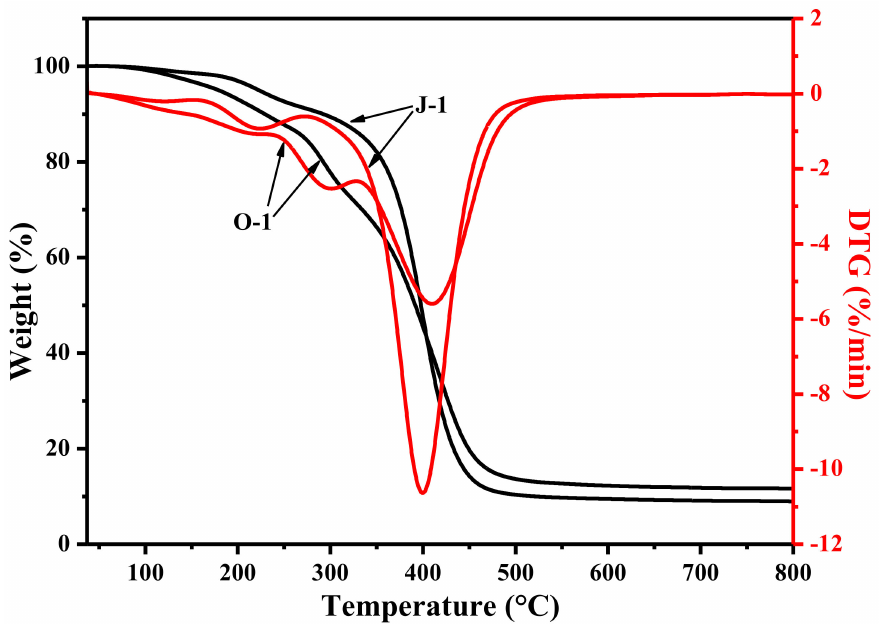
Figure 6. The effect of crosslinking on the heat resistance of the fiber; fiber O-1 is defined in Section 2.3, and fiber J-1 is described in Section